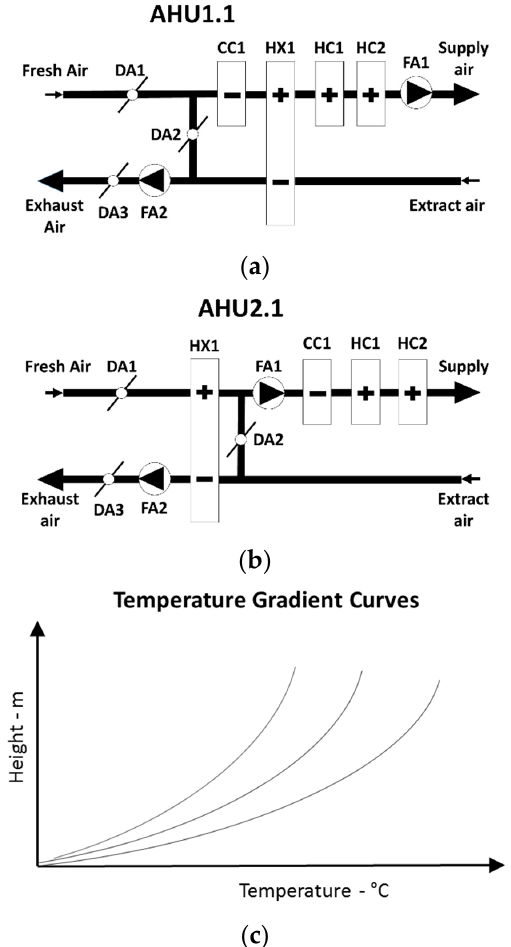
Figure 1. AHU layouts and temperature gradient curves. ( a ) Schematic view of AHU1.1; ( b ) Schematic view of AHU 2.1; ( c ) Estimated models for temperature